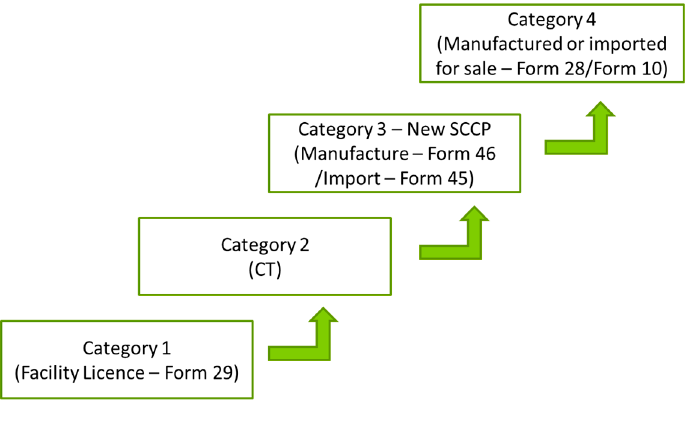
Figure 4. Process workflow clinical trial licenses and approvals.